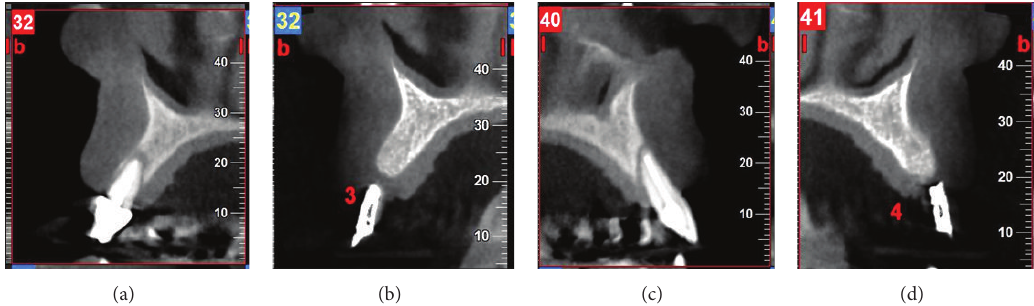
Figure 8: Radiographic views of Case 3. CBCT images at (a, c) pretreatment and (b, d) 6 months